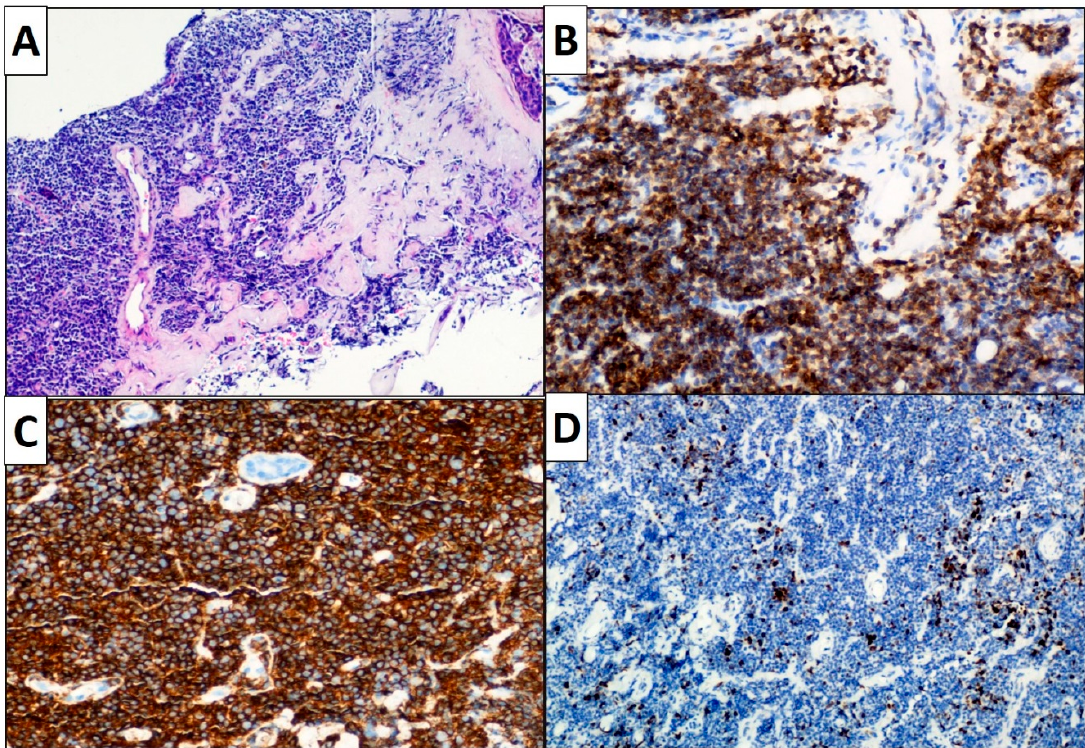
Figure 4. Primary breast marginal zone NHL is characterized by diffuse proliferation of small to medium-sized lymphoid cells and accompanied by stromal sclerosis and residual atrophic ducts (( A ): hematoxylin and eosin, original magnification X40). The neoplastic lymphocytes are strongly immunoreactive for bcl2 (( B ): original magnification X200) and CD20 (( C ): original magnification X200). The immunohistochemical stain for Ki67 shows a very low proliferative index, pointing at an “indolent” lymphoma (( D ): original magnification X100).